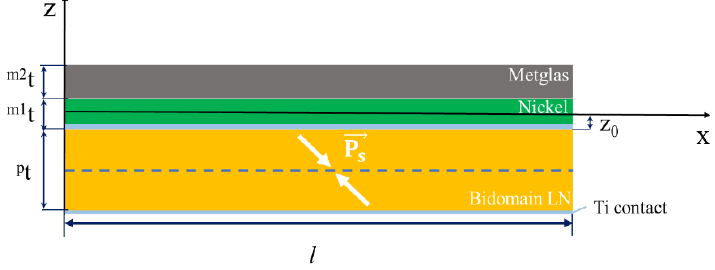
Figure 1. Schematic view of the magnetoelectric (ME) gradient structure.